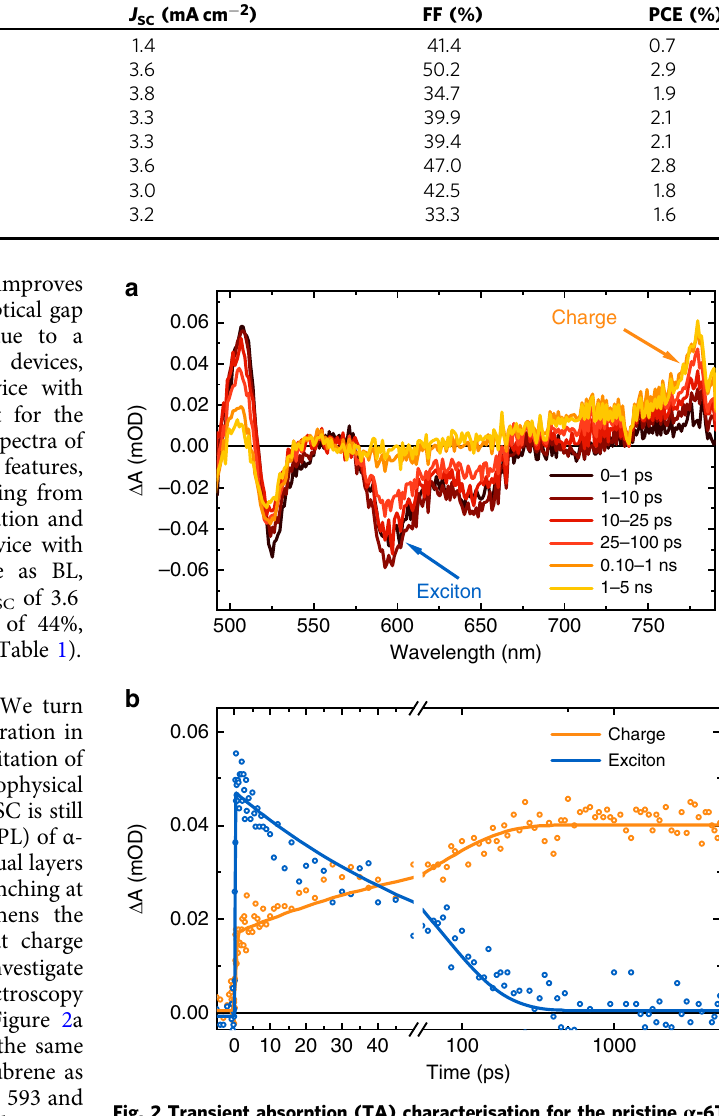
Table 1 Photovoltaic parameters of organic solar cells based on α -6T with various buffer layers. Device structure